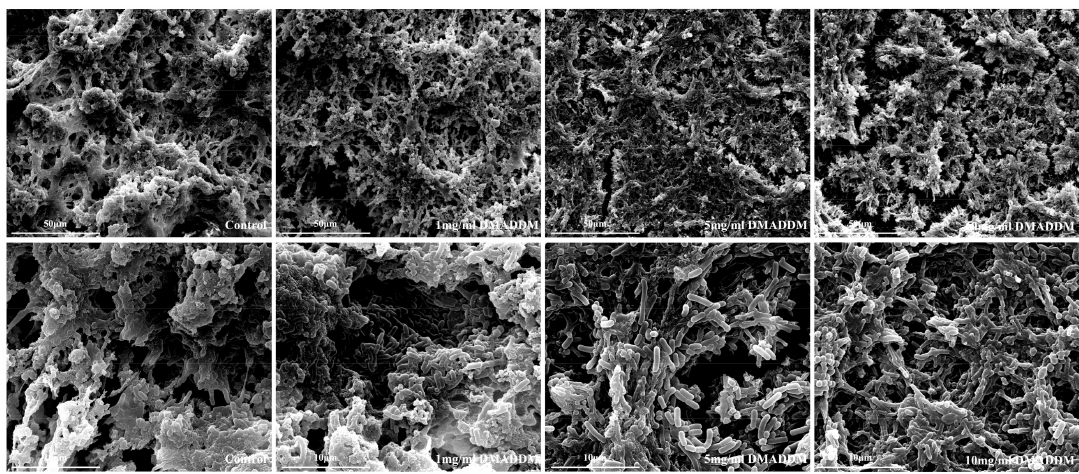
Figure 4. Scanning electron microscopy (SEM) micrographs of saliva-derived biofilms on titanium